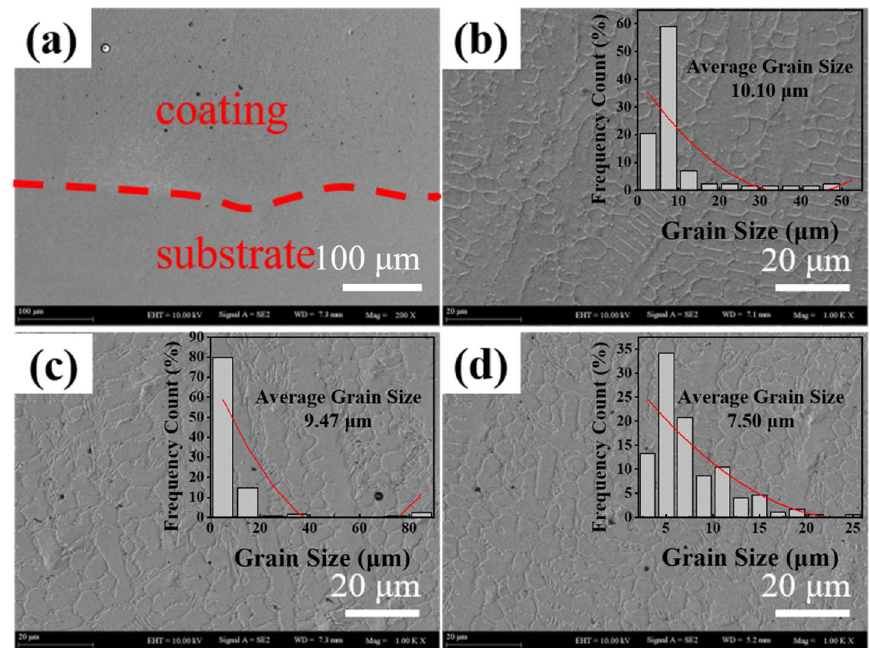
Figure 3. Microstructure of Al x Ti 1− x ( x = 0, 0.5, 1) HEA’s coatings: ( a ) Cross-section morphology